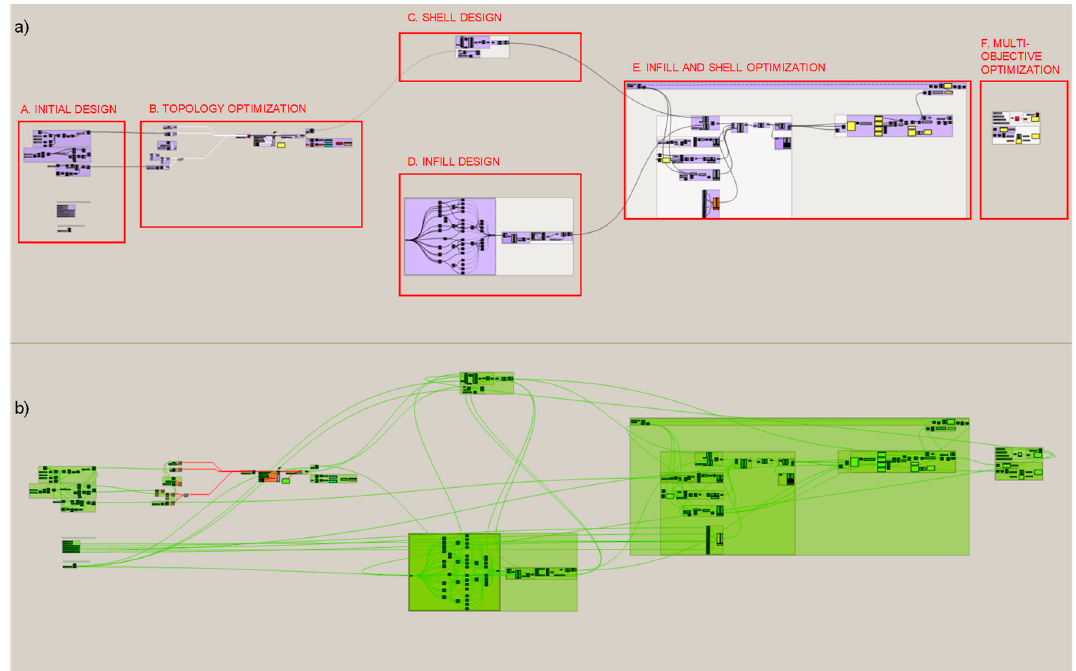
Figure 7. Visual programming structure of the proposed methodology for the case study developed